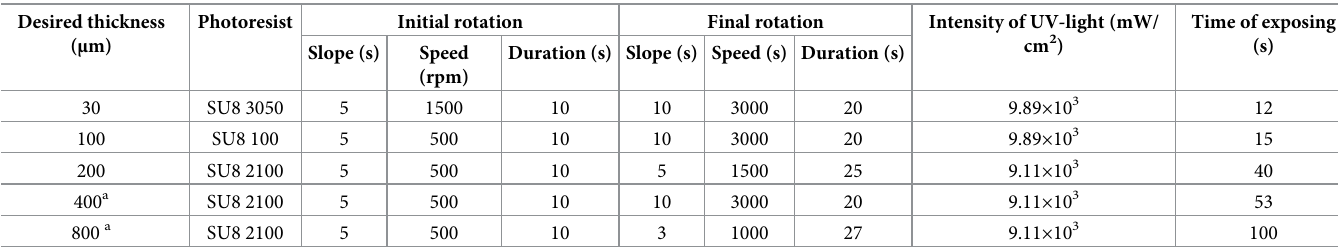
Table 1. The conditions of spin